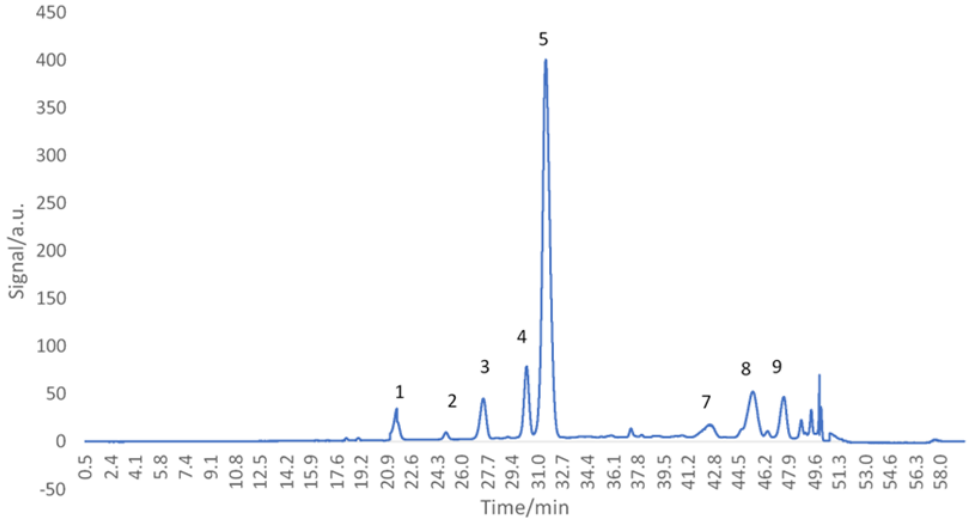
Figure 1. HPLC chromatograms of anthocyanin/anthocyanidin profile of Băbească neagră grape skin at 520 nm. Table 1. The compounds detected in untreated extracts of grape skins by HPLC.